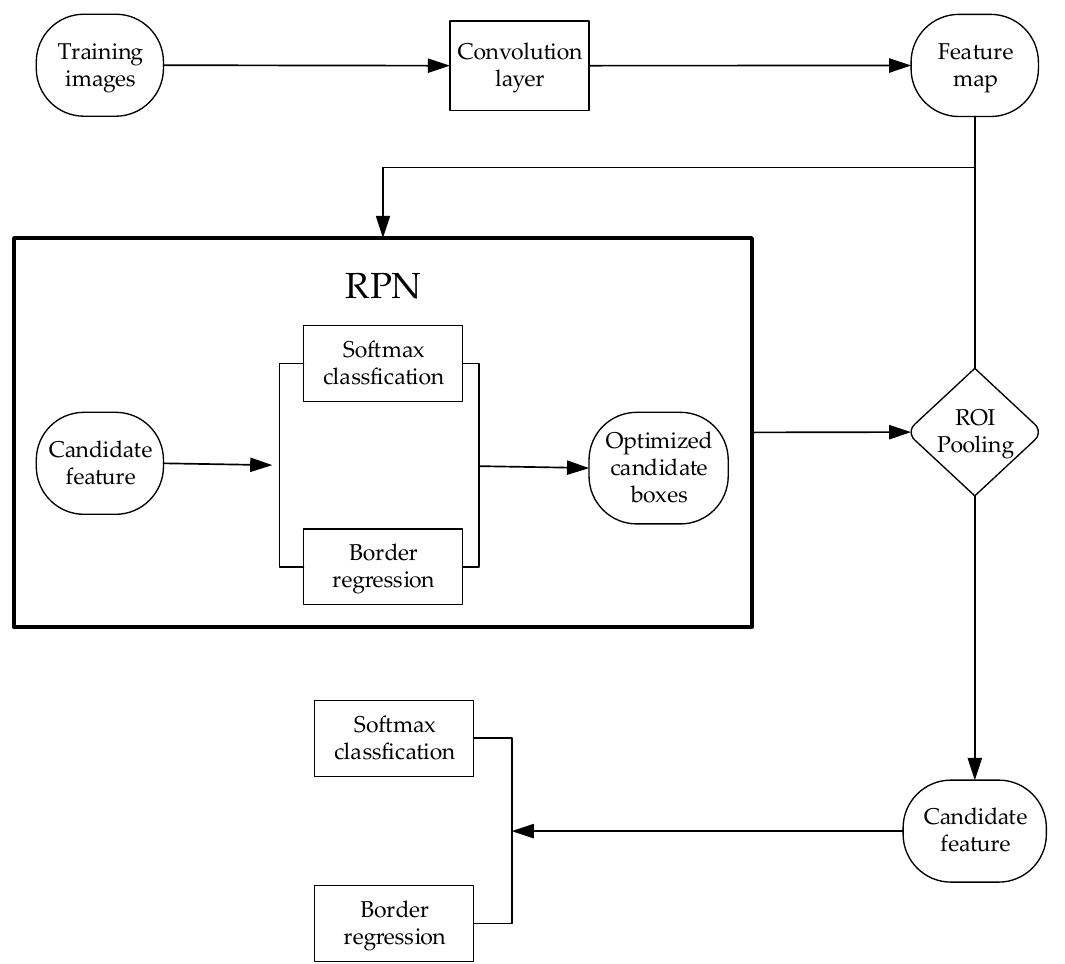
Figure 7. The structure of the Faster-Region Convolutional neural network (Faster-RCNN) model.